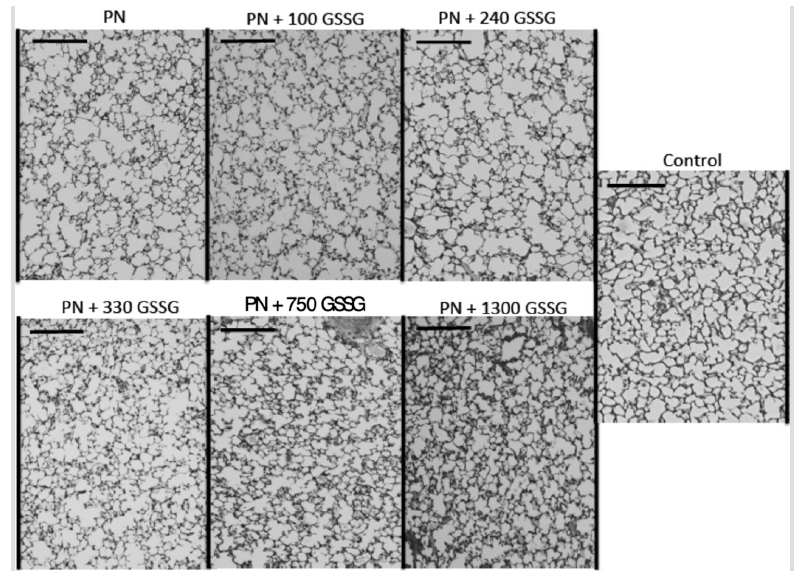
Figure 5. Representative pictures of a histological preparation of each group studied. Control: animals of the same age without any manipulation other than being fed with standard Guinea pig food ; PN: parenteral nutrition ; GSSG: dose of disulphide form of glutathione expressed in µg/kg/d. Bar on each sub-picture: 0.2 mm.